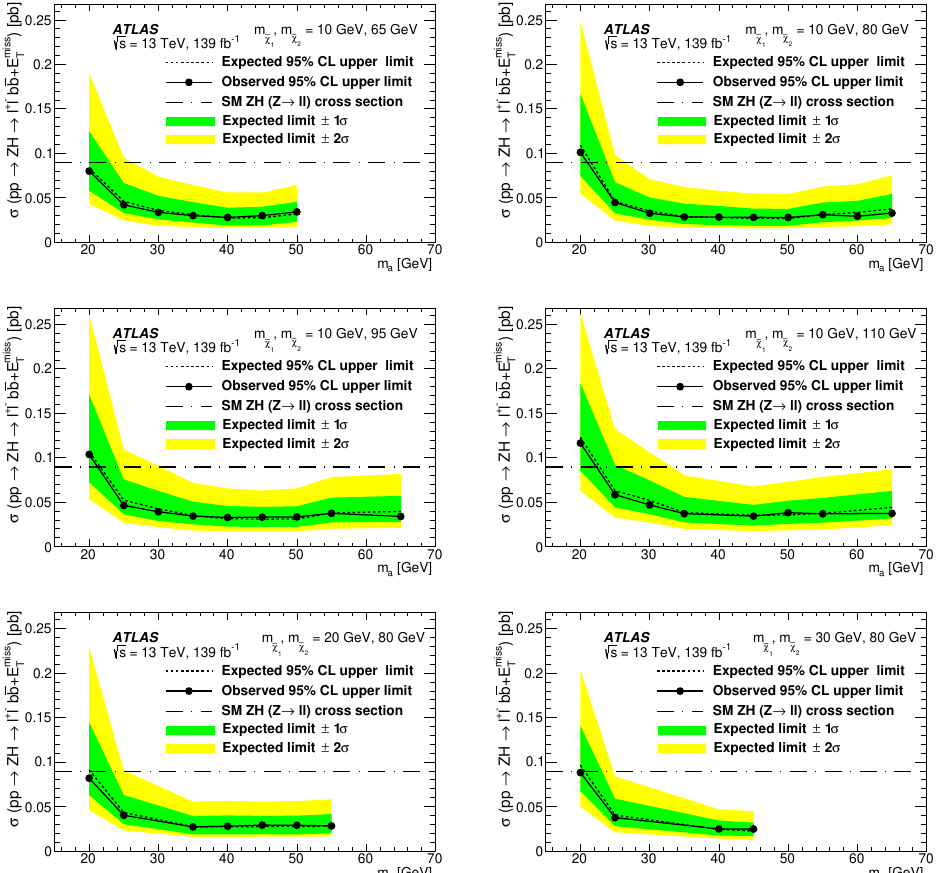
Figure 3. Upper limits at 95% CL on the pp → ZH cross section times the branching ratio for 0 0 ¯ ˜ χ 0 ˜ χ 0 ˜ χ 0 ˜ χ 0 as a function of m for Z → ‘ + ‘ − (where ‘ = e, µ or τ ) and H → ˜ χ b ˜ χ 2 1 → a 1 1 → b 1 1 a several values of m and m for the NMSSM scenario described in the text. All branching ratios ˜ χ 0 1 ˜ χ 0 2 ˜ χ 0 in the decay chain after the decay H → ˜ χ 0 are set to 100%. The different ranges of m points 2 1 a on the horizontal axis reflect differences in the allowed event kinematics. The green and yellow bands show respectively the ± 1 σ and ± 2 σ ranges for the expected limits. The lines joining the m a points come from an assumed linear interpolation of the limits. The SM value for the cross section σ ( pp → ZH ) × BR ( Z → ‘ + ‘ − ) is shown for